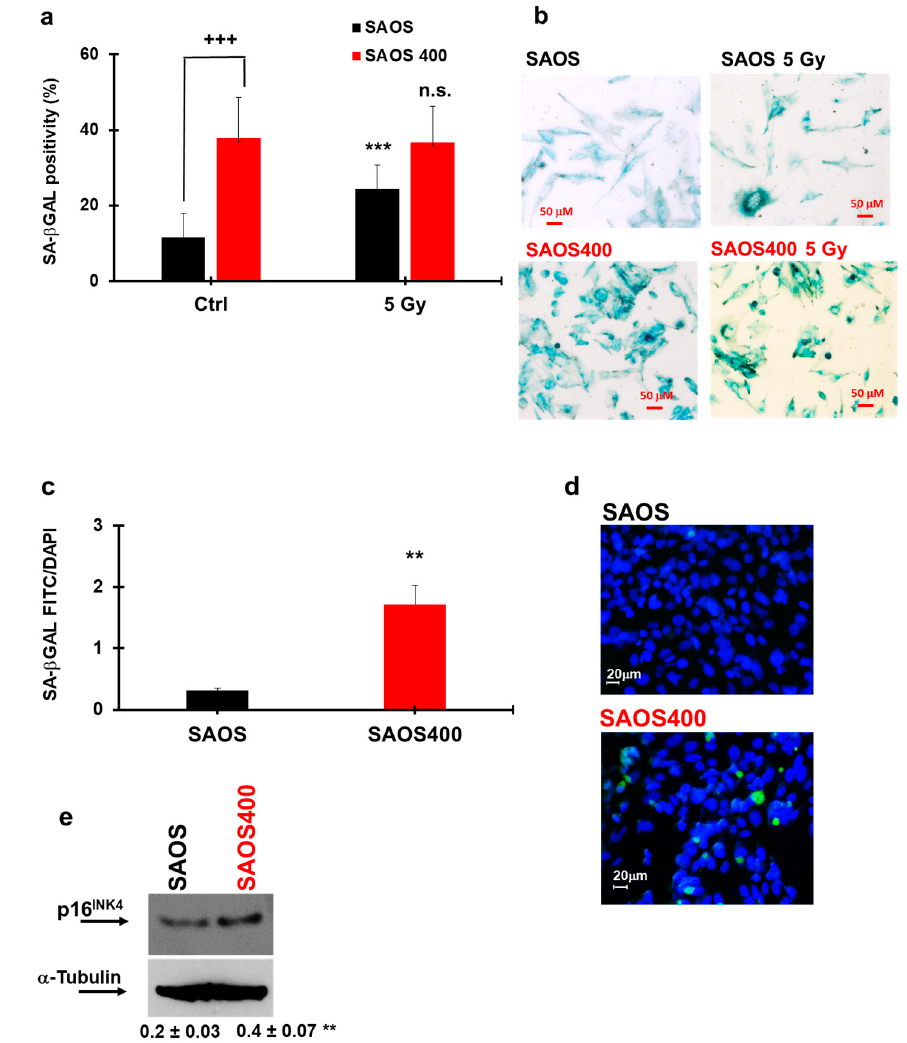
Figure 6. Senescence measurements in SAOS and SAOS400 cell lines. SA- β Gal staining in SAOS and SAOS400 cells before and after irradiation (5 Gy) were quantified (panel a ) and microscopically visualized (panel b ). The results of a different protocol that employed C 12 FDG staining were also quantified (panel c ), and representative images were reproduced ( d ). Bar graphs represent the mean ± SD of two independent experiments. Symbols indicate significance: +++ p < 0.001 for untreated SAOS vs. untreated SAOS400 cells; *** p < 0.001 for untreated SAOS vs. irradiated SAOS (black bars); n.s. not significant in SAOS400 before and after irradiation (red bars) One-way ANOVA with Bonferroni’s multiple comparisons test was used. Panel ( e ) reports the immunoblot showing the basal expression of p16 INK4 in SAOS and SAOS400 cells. Numbers between panels indicate the densitometric analysis ± SD of three independent experiments. Symbols indicate significance: ** p < 0.01 vs. SAOS (T-Test